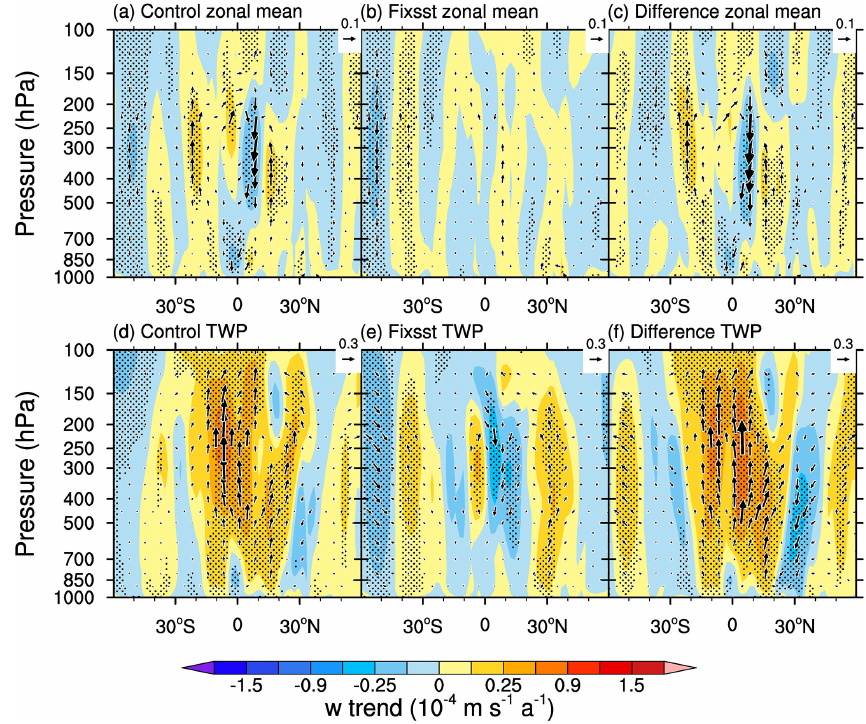
Figure 11. Same as Fig. 10 but for the trends of tropospheric w (10 − 4 ms − 1 a − 1 ) and v (10 − 1 ms − 1 a − 1 ). The shadings denote the trends of the w (10 − 4 ms − 1 a − 1 ). The trends over the dotted regions are statistically significant at the 90% confidence